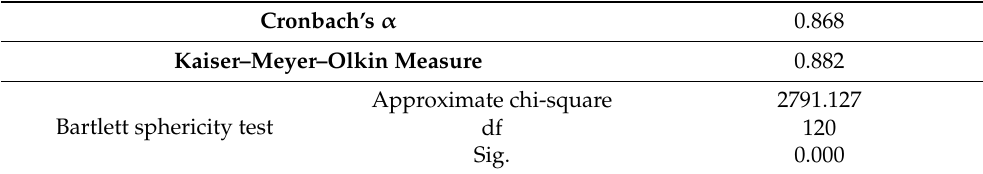
Table 3. Reliability and validity test statistics. Number of variables = 16, n =